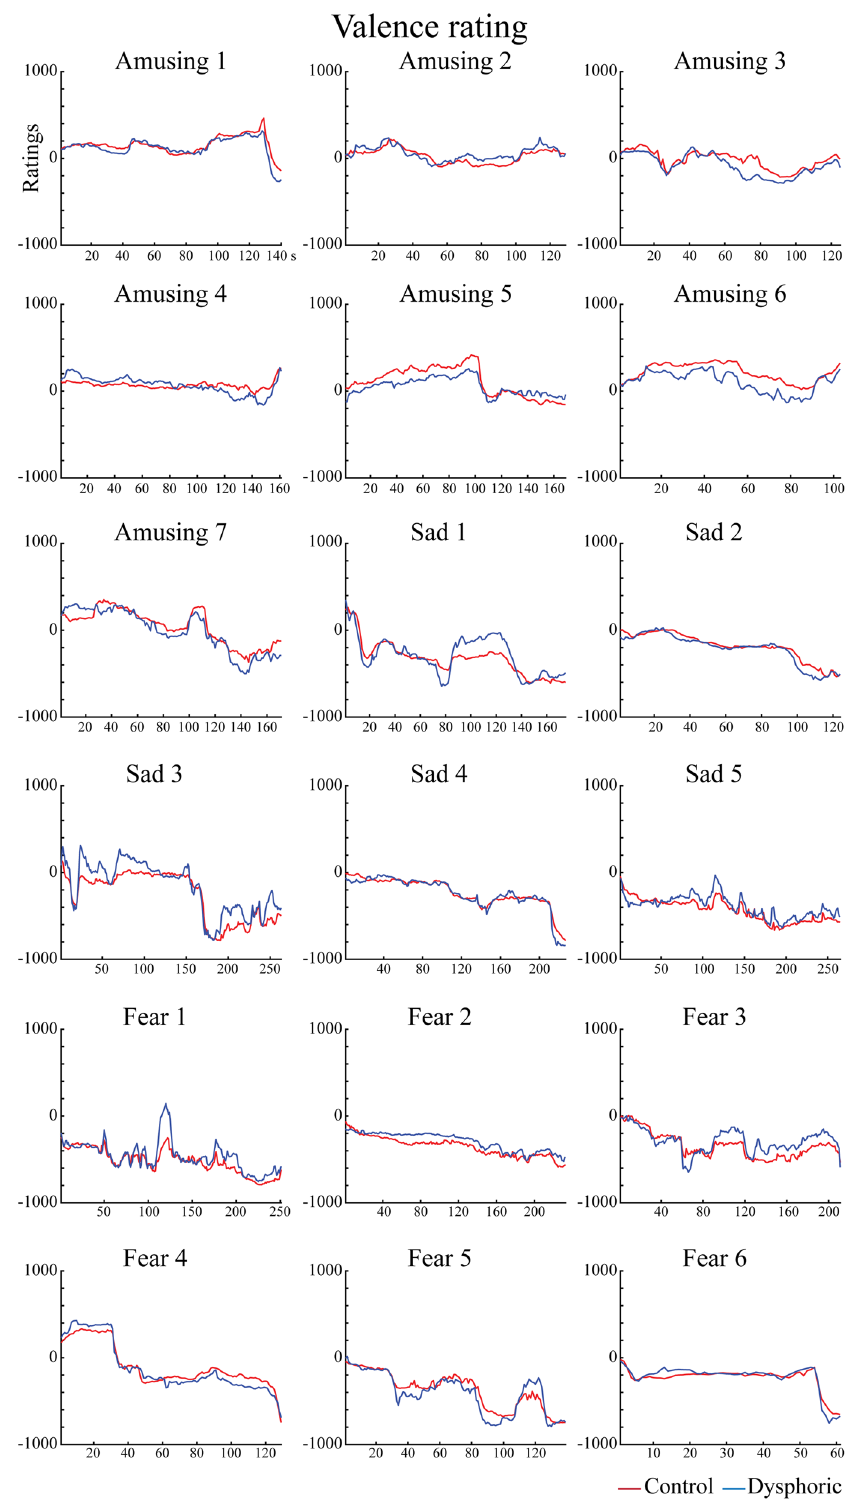
Figure 2. Dynamic valence ratings separately for each movie and research group. Here the ratings range from −1000 to 1000 on an artificial scale. Data of movie Amusing 3 were excluded for the statistical analysis of the EDA responses and valence ratings, because the average value over the timepoints for valence for this amusing movie clip was